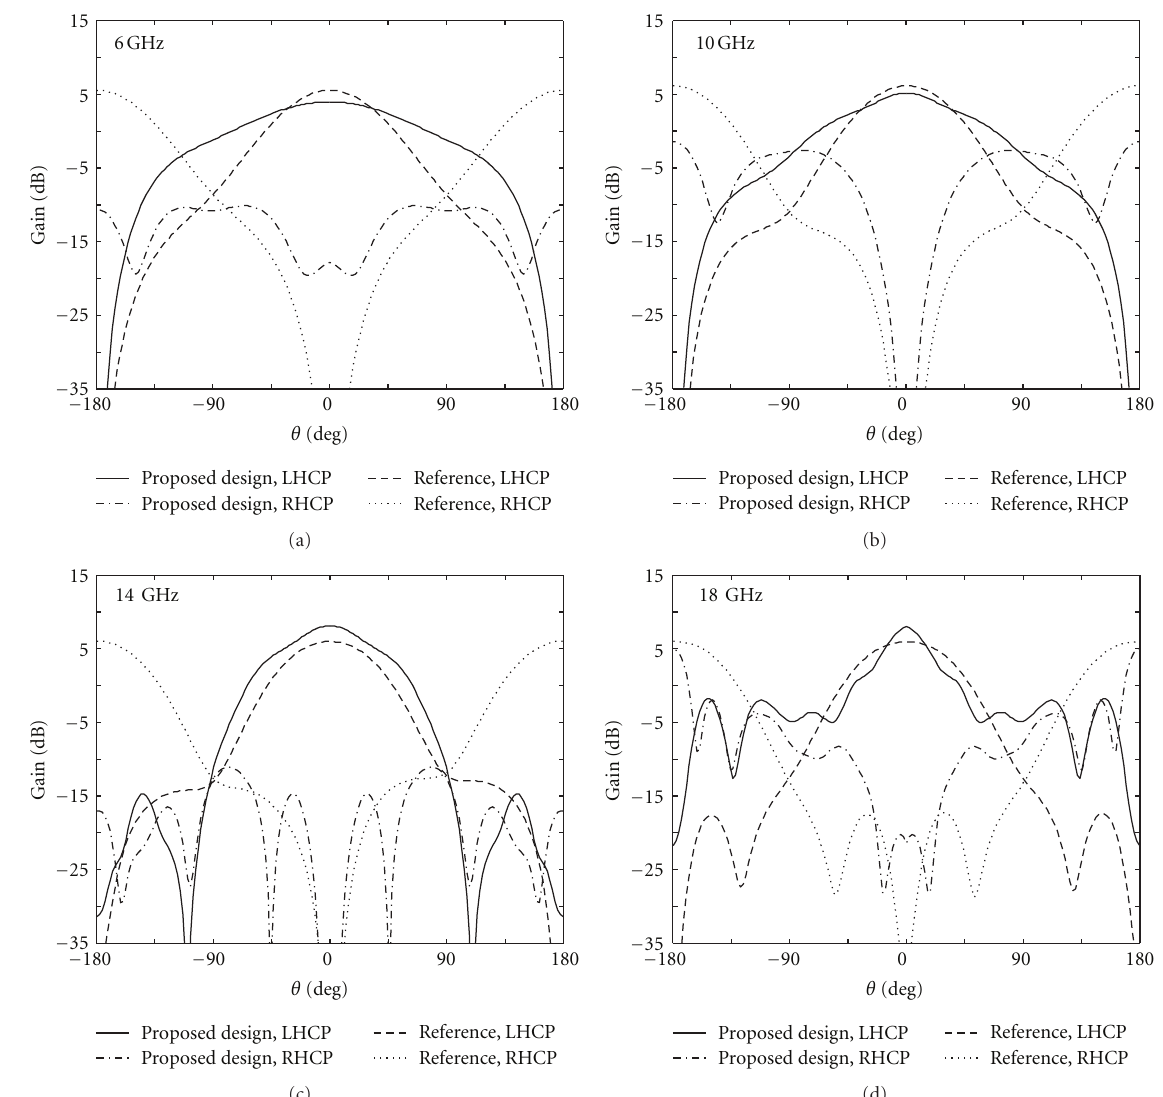
Figure 6: Simulated far-field patterns of the structure backed by a conical ground plane φ = 0 compared to the free space sinuous antenna